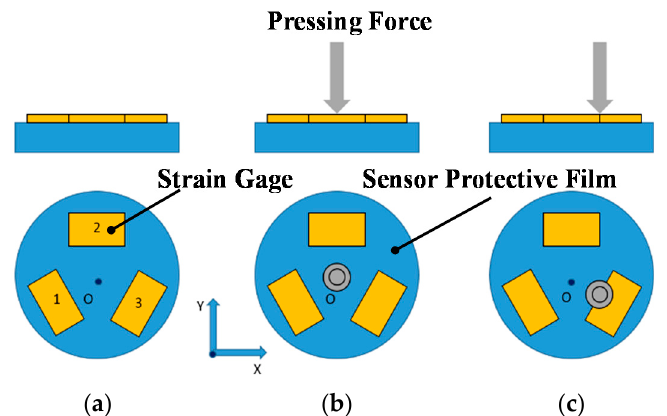
Figure 2. Schematic of the proposed pressing force sensor. ( a ) No force applied. ( b ) Centric force applied. ( c ) Eccentric force applied.